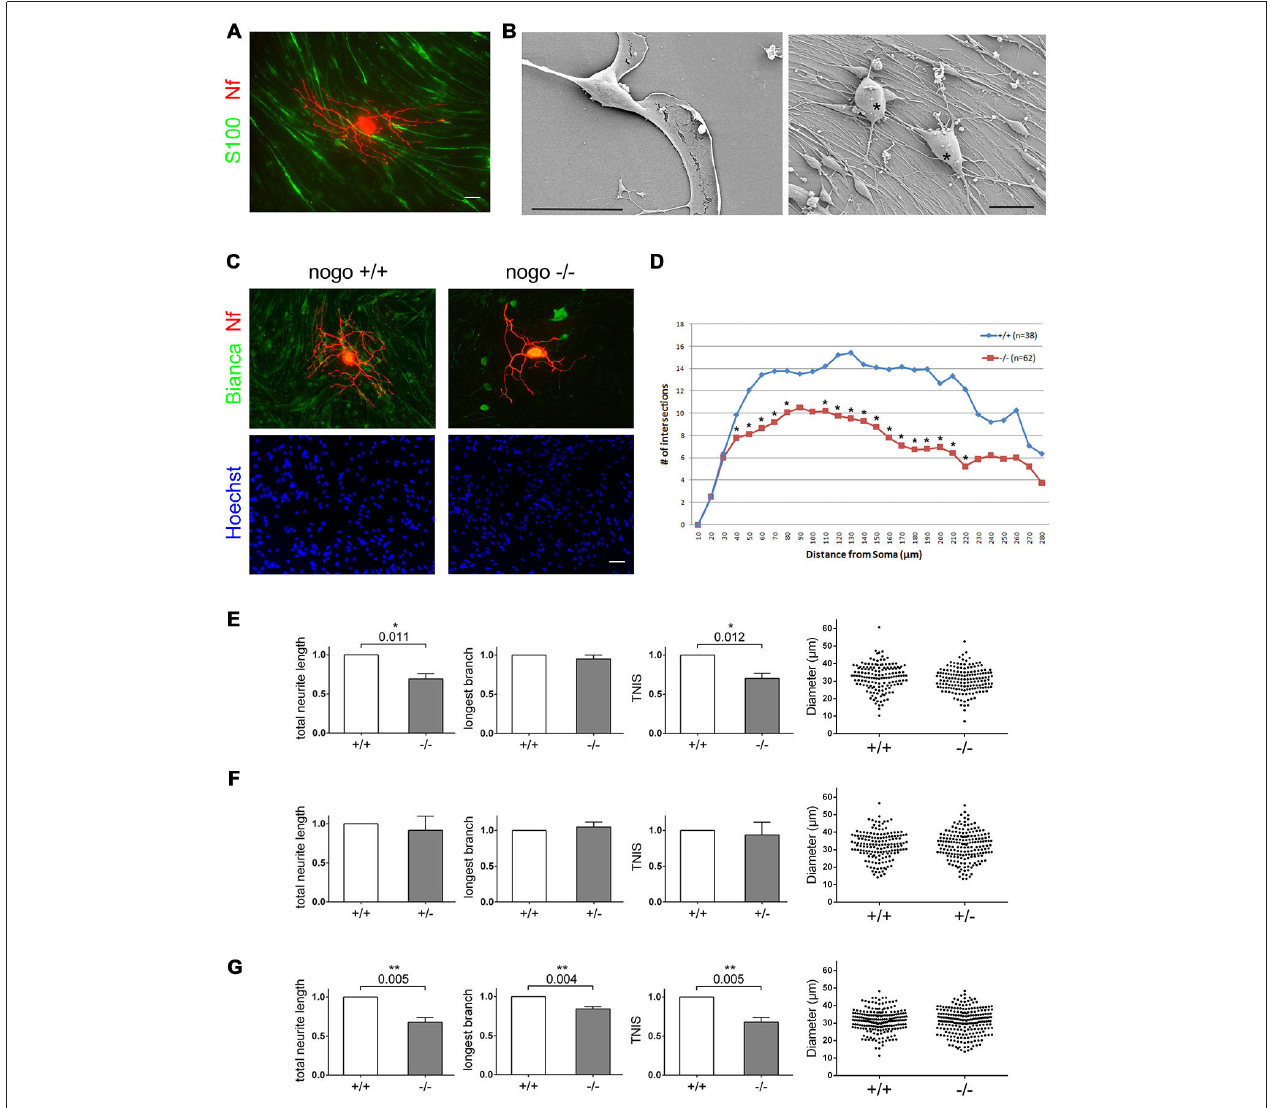
FIGURE 3 | Deletion of Nogo-B in Schwann cells reduces the extent of neuronal branch formation. (A) DRG-derived sensory neurons are cultured on a high density Schwann cell monolayer. Schwann cells are stained with S100ß, neurons with a neurofilament antibody. Scale bar is 10 µ m. (B) SEM images of an individual Schwann cell and the Schwann cell neuron co-culture. Neurons are marked with an asterisk. Scale bar is 20 µ m. (C) Wildtype sensory neurons from an adult mouse are cultured on nogo + / + and nogo − / − Schwann cells. The co-culture is stained with Bianca, Hoechst, and a neurofilament antibody. Scale bar is 10 µ m. (D) Sholl analysis of neurons grown on nogo + / + vs. nogo − / − Schwann cells. n denotes the number of neurons analyzed per Schwann cell genotype. Asterisks indicate statistically significant differences in the number of intersections per increment. (E) Quantification of morphological parameters of adult wildtype sensory neurons grown on nogo + / + vs. nogo − / − Schwann cells. TNIS denotes the total number of intersections of a neuron’s neurites in the Sholl analysis whereas TNL is the total neurite length (TNL). Five independent experiments were carried out with a total of 148 neurons being analyzed in the wildtype and 163 neurons in the knockout group. Morphological parameters were normalized to the wildtype control (set to 1.0) and expressed as mean ± SEM. P -values ≤ 0.05 are indicated. In the knockout TNIS is reduced to 0.71 and TNL to 0.69 relative to the wildtype levels. Neuronal cell body diameters are depicted in a dot blot. (F) Quantification of morphological parameters of adult wildtype sensory neurons grown on nogo + / + vs. nogo + / − Schwann cells. Five independent experiments were carried out with a total of 161 neurons being analyzed in the wildtype and 185 neurons in the heterozygous group. Morphological parameters were normalized to the wildtype control (set to 1.0) and expressed as mean ± SEM. P -values ≤ 0.05 are indicated. Neuronal cell body diameters are depicted in a dot blot. (G) Quantification of morphological parameters of sensory neurons obtained from wildtype p6–9 mice grown on nogo + / + vs. nogo − / − Schwann cells. Five independent experiments were carried out with a total of 209 neurons being analyzed in the wildtype and 232 neurons in the knockout group. Morphological parameters were normalized to the wildtype control (set to 1.0) and expressed as mean ± SEM. P -values ≤ 0.05 are indicated. In the knockout both TNIS and TNL are reduced to 0.68 relative to the wildtype levels. The longest branch (LB) value is reduced to 0.84 relative to wildtype. Neuronal cell body diameters are depicted in a dot blot.